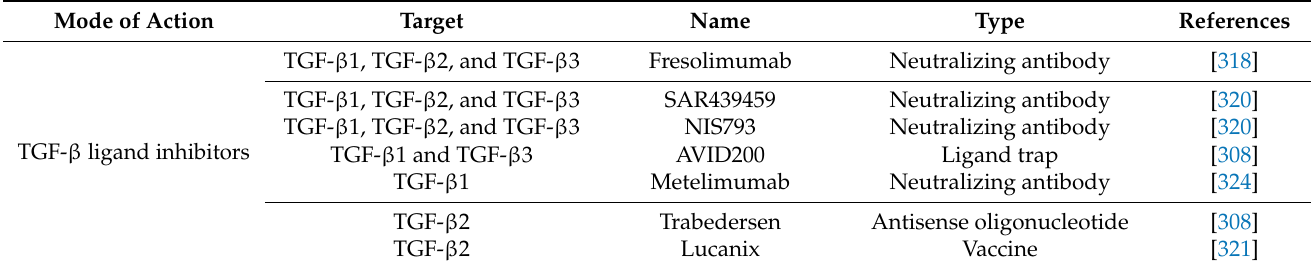
Table 3. Different strategies targeting TGF- β signaling components for cancer therapy. Mode of